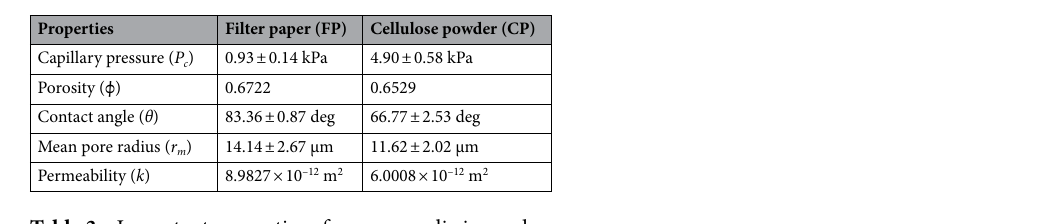
Table 3. Important properties of porous media in